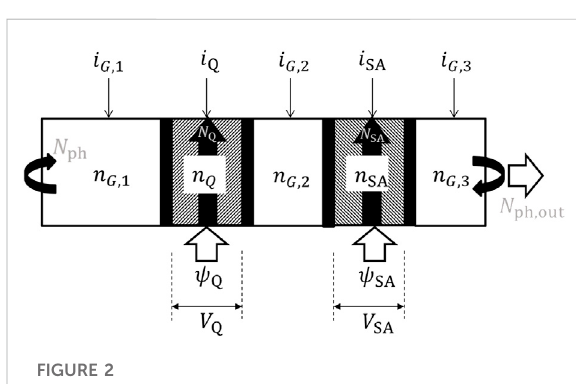
FIGURE 2 Schematic view of the neuron laser detailing the different variables of the